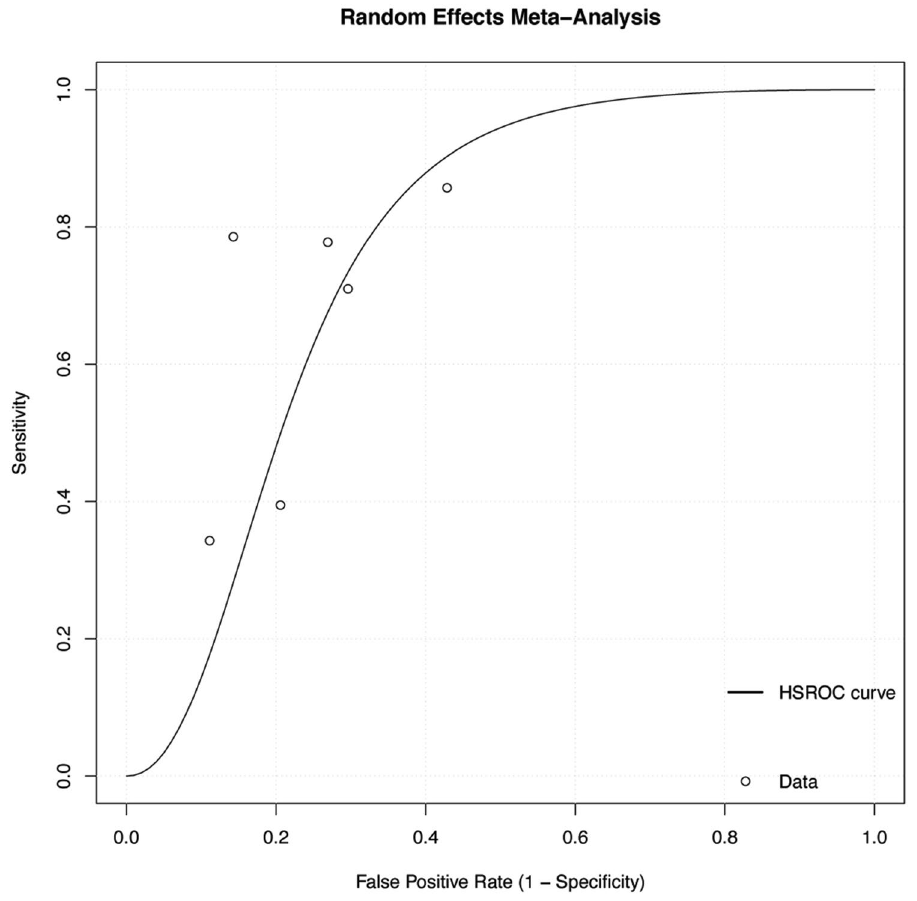
Figure 4. HSROC curve. HSROC, hierarchical summary receiver operating